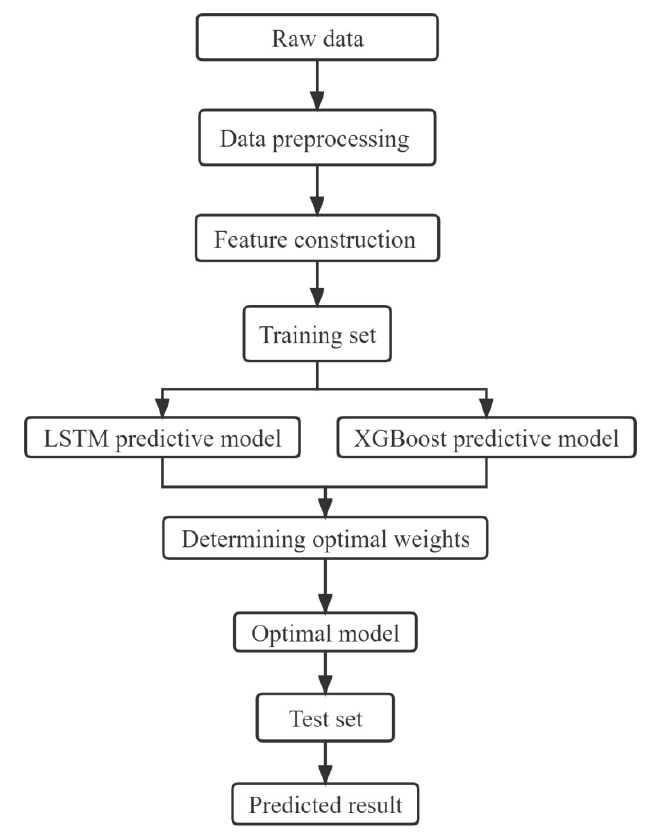
Figure 2. The overall forecasting model architecture.